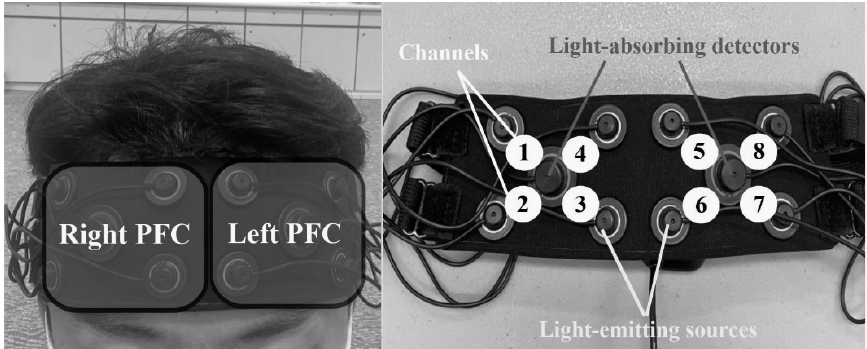
Figure 2. Optodes position of fNIRS device. 1-8 are channel